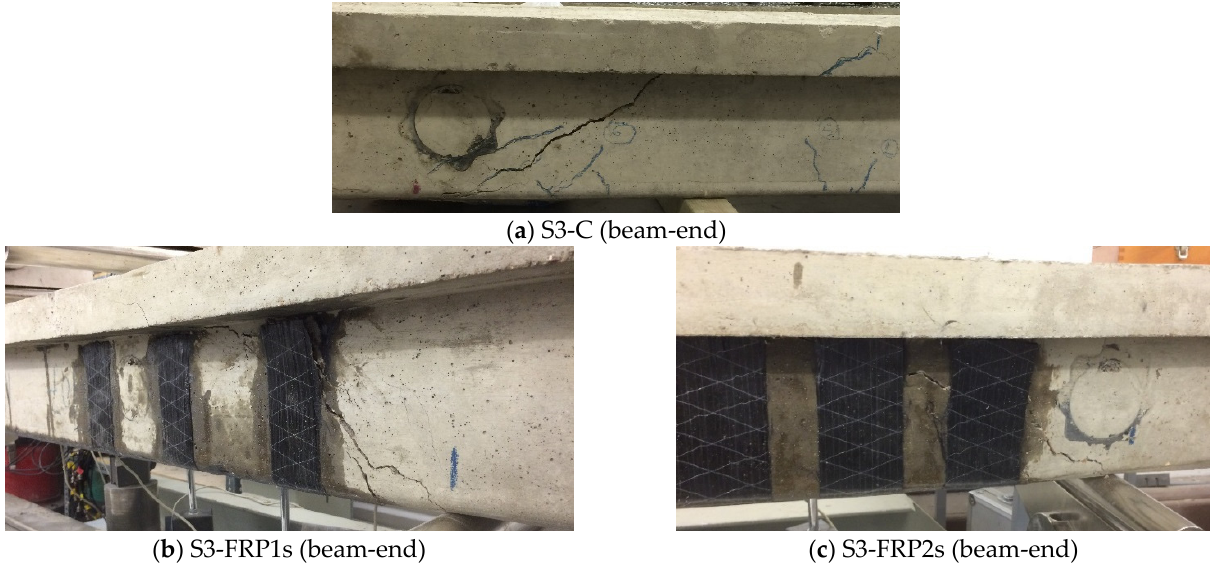
Figure 8. Observed failure in beams of series 3—( a ) S3-C, ( b ) S3-FRP1s and ( c ) S3-FRP2s.